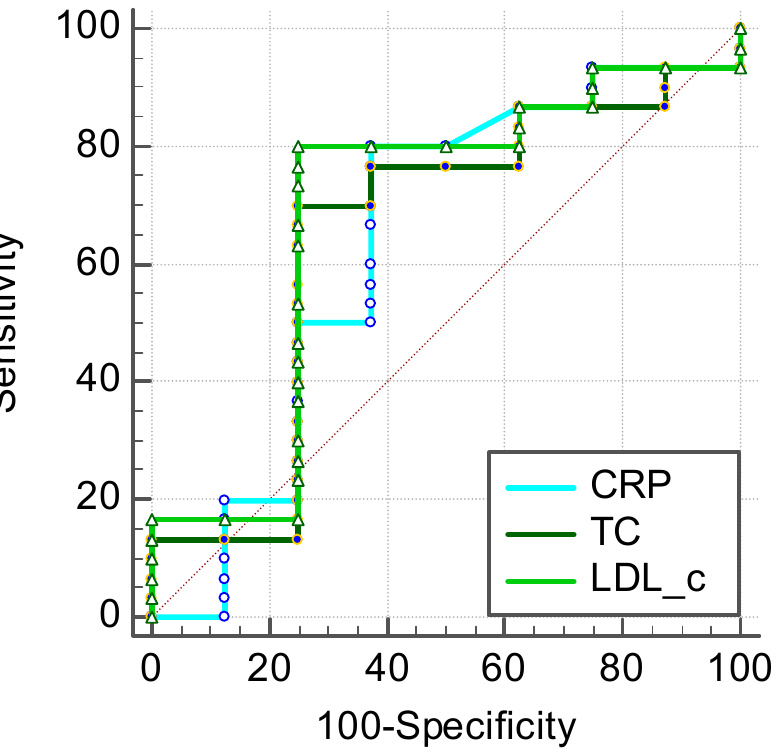
Figure 2. Prognostic values of CRP, TC, and LDL-c in the prediction of a 2-month complication of any cause after heart transplant.